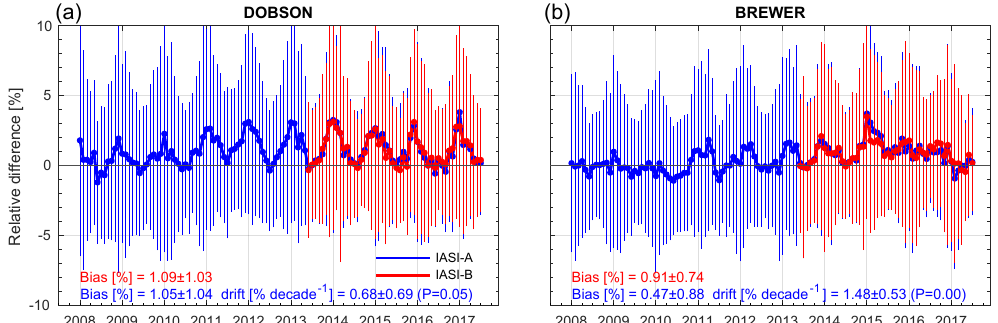
Figure 10. Time series of the monthly relative differences (in percent) between IASI-A (blue) and IASI-B (red) against collocated ground- based (GB) TOC for the Northern Hemisphere for the Dobson (a) and Brewer (b) networks. For each daily GB measurement, a relative difference is calculated as 100 × (IASI − GB) / GB [%]. All the relative differences are then monthly averaged. For the period from May 2013 onwards, only the common collocations between IASI-A and IASI-B are shown. The 1 σ standard deviation of the average is also displayed (vertical bars). Comparison statistics including the mean bias and its 1 σ standard deviation in percent for the 2008–2017 period (IASI-A) and 2013–2017 period (IASI-B) are indicated on each panel. The decadal drift, its 2 σ standard deviation (in percent) and the P value for the IASI-A time series are also indicated on each